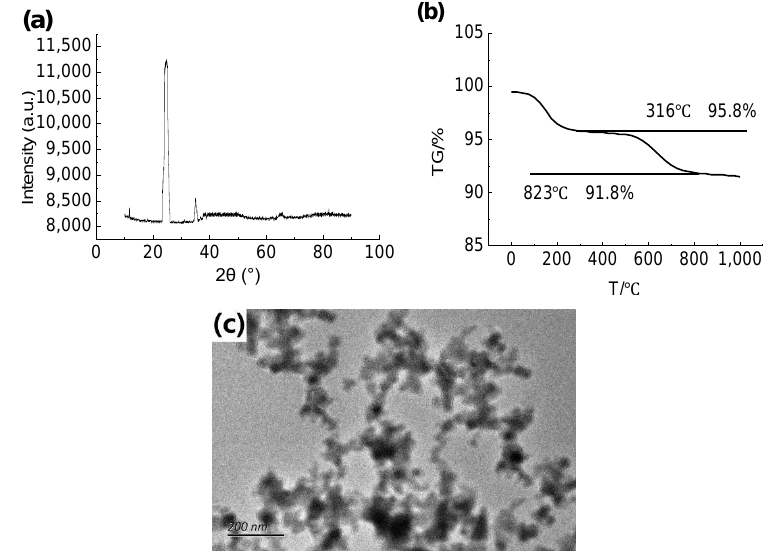
Figure 2. ( a ) Spectra of SiO 2 , ( b ) TG and ( c ) TEM images of SiO